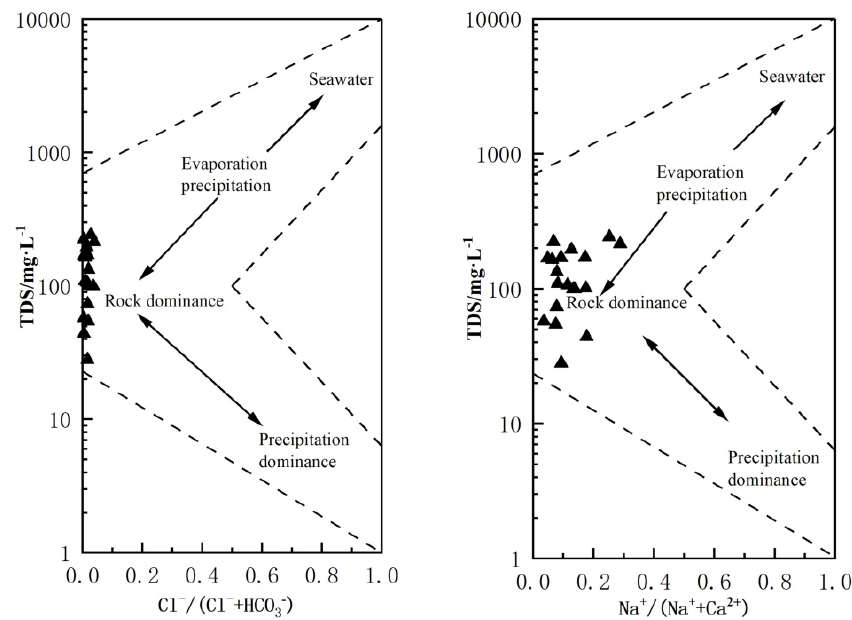
Figure 4. Gibbs plots for natural water in the study area. Table 2. Correlation coefficients among various water chemical parameters of the natural